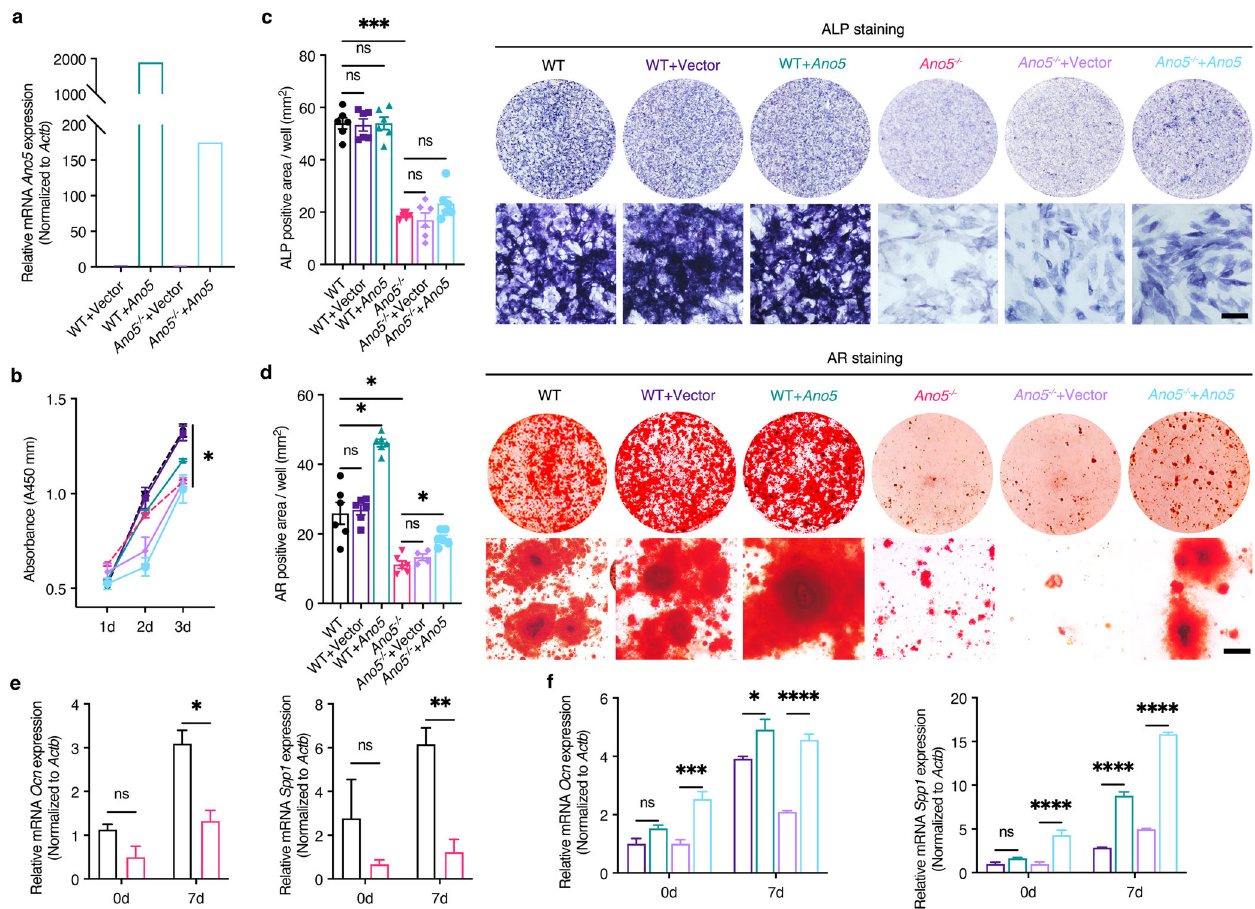
Fig. 3 Ano5 positively regulates osteoblast differentiation. a Overexpression of Ano5 in cells transduced with lentivirus was con fi rmed by qPCR. b The proliferation of WT and Ano5 − / − calvarial osteoblasts and those transduced with a control vector or Ano5 overexpression lentivirus by CCK-8 assay. c Representative images and quanti fi cation of ALP staining after 7 days of osteogenic differentiation. d Representative images and quanti fi cation of AR staining after 21 days of osteogenic differentiation. e Relative mRNA expression of Ocn and Spp1 in osteoblasts differentiated from WT and Ano5 − / − calvarial osteoblasts and f those transduced with a control vector or Ano5 overexpression lentivirus as a function of time in culture. Scale bar, 50 µm. All results are representative of data generated from at least three independent experiments. Data are represented as the mean ± SEM. Two-way ANOVA followed by Tukey ’ s multiple comparisons test. * P < 0.05, ** P < 0.01, *** P < 0.001, **** P < 0.0001; ns: not signi fi cant P >